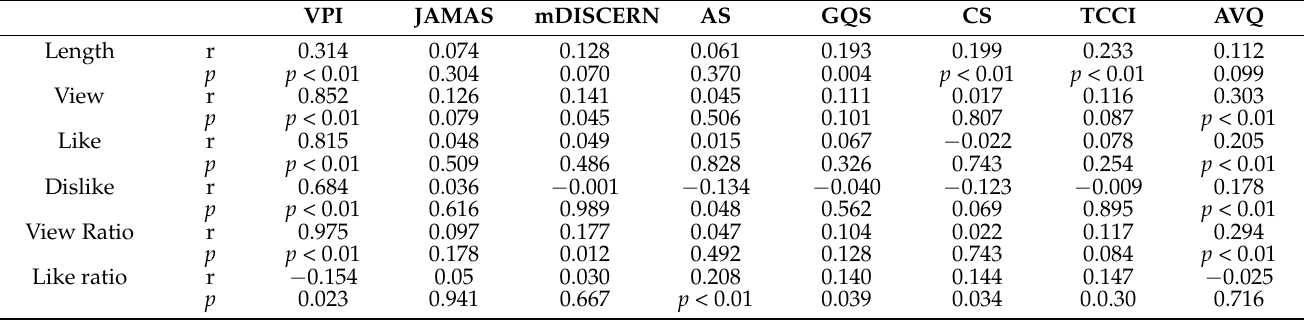
Table 4. Assessment of the relationship between quantitative variables and